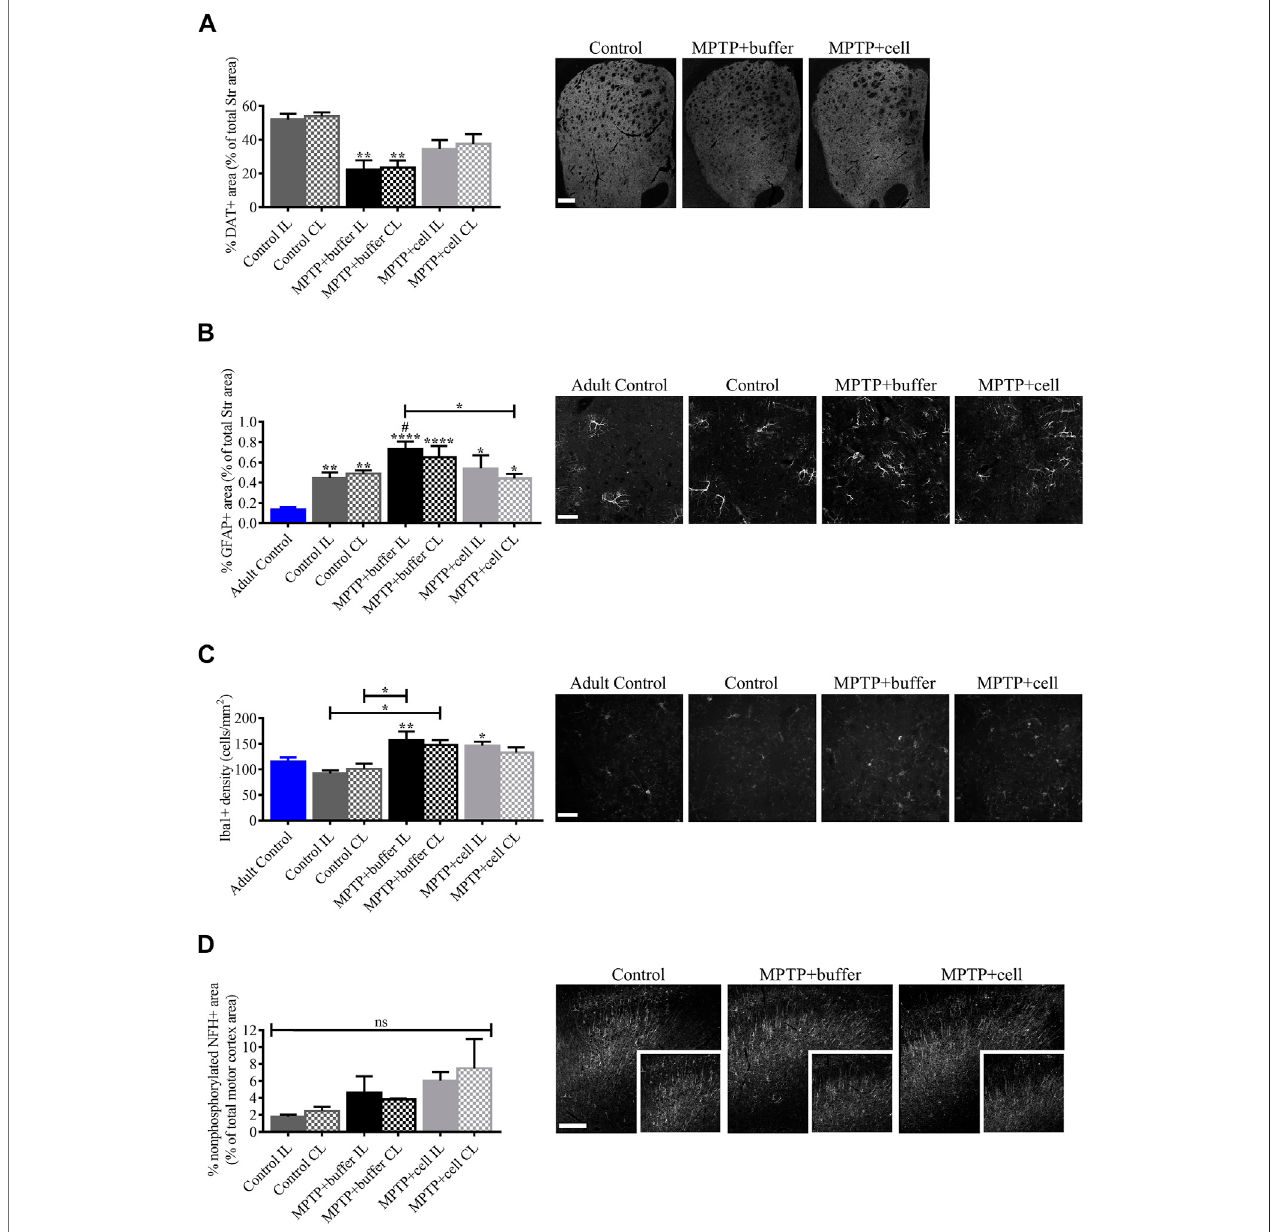
FIGURE 6 | Evaluation of factors that potentially in fl uenced hNSC transplant including DA transport, in fl ammation, and motor cortex alterations. (A) Compared to controls, DAT immunostaining decreased by approximately 57% in buffer-treated mice ( p < 0.01) and non-signi fi cantly by around 32% in cell-transplanted animals, althoughDAT+areatendedtobeincreasedby36%inhNSC-treatedmicecomparedtothosethatreceivedbuffer.Control n (cid:1) 3,MPTP+buffer n (cid:1) 4,MPTP+cell n (cid:1) 4. (B) StriatalexpressionofGFAPtendedtobehigherinbuffer-treatedanimals,reachingstatisticalsigni fi canceontheILside( p < 0.05),andwasdecreasedontheCL side of hNSC-transplanted mice compared to the IL side of buffer-treated animals ( p < 0.05). When compared to adult control mice, all middle-aged mice had increased GFAPexpressionintheStr( p < 0.05).AdultControl n (cid:1) 3,Controln (cid:1) 5,MPTP+buffer n (cid:1) 4,MPTP+cell n (cid:1) 3.One-wayANOVAfollowedbyTukey ’ spost-hoctest.*, # (cid:1) p < 0.05, ** (cid:1) p < 0.01, **** (cid:1) p < 0.0001. * (cid:1) compared to adult control, # (cid:1) compared to same brain hemisphere of middle-aged control. Data are expressed as mean ± standarderrorofthemean.Scalebar (cid:1) 50 μ m. (C) Iba1+microglialpopulationswereincreasedintheStrofallParkinsonianmice( p < 0.05),andagedidnotaffectmicroglial density. Adult Control n (cid:1) 5, Control n (cid:1) 4, MPTP + buffer n (cid:1) 5, MPTP + cell n (cid:1) 5. One-way ANOVA followed by Tukey´s post-hoc test. * (cid:1) p < 0.05, ** (cid:1) p < 0.01. * (cid:1) compared to same brain hemisphere of middle-aged control. Data are expressed as mean ± standard error of the mean. Scale bar (cid:1) 50 μ m. (D) In the motor cortex, nonphosphorylatedNFH+areatendedtobeincreasedinanimalsintoxicatedwithMPTPby50 – 69%comparedtocontrolmice.Control n (cid:1) 3,MPTP+buffer n (cid:1) 3,MPTP+ cell n (cid:1) 3. (A,D) : One-way ANOVA followed by Tukey ’ s post-hoc test. ** (cid:1) p < 0.01, ns, not signi fi cant. * (cid:1) compared to same brain hemisphere of control. Data are expressed as mean ± standard error of the mean. Scale bars (cid:1) 200 μ m.